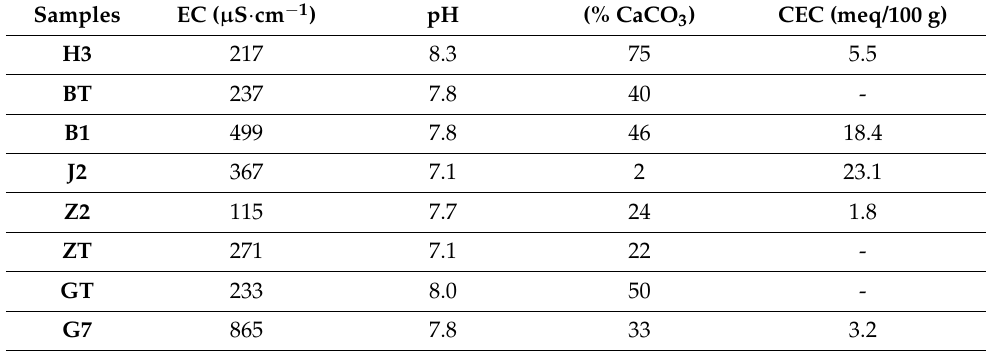
Table 3. pH and EC values and calcium carbonate content of soil samples from the study areas.